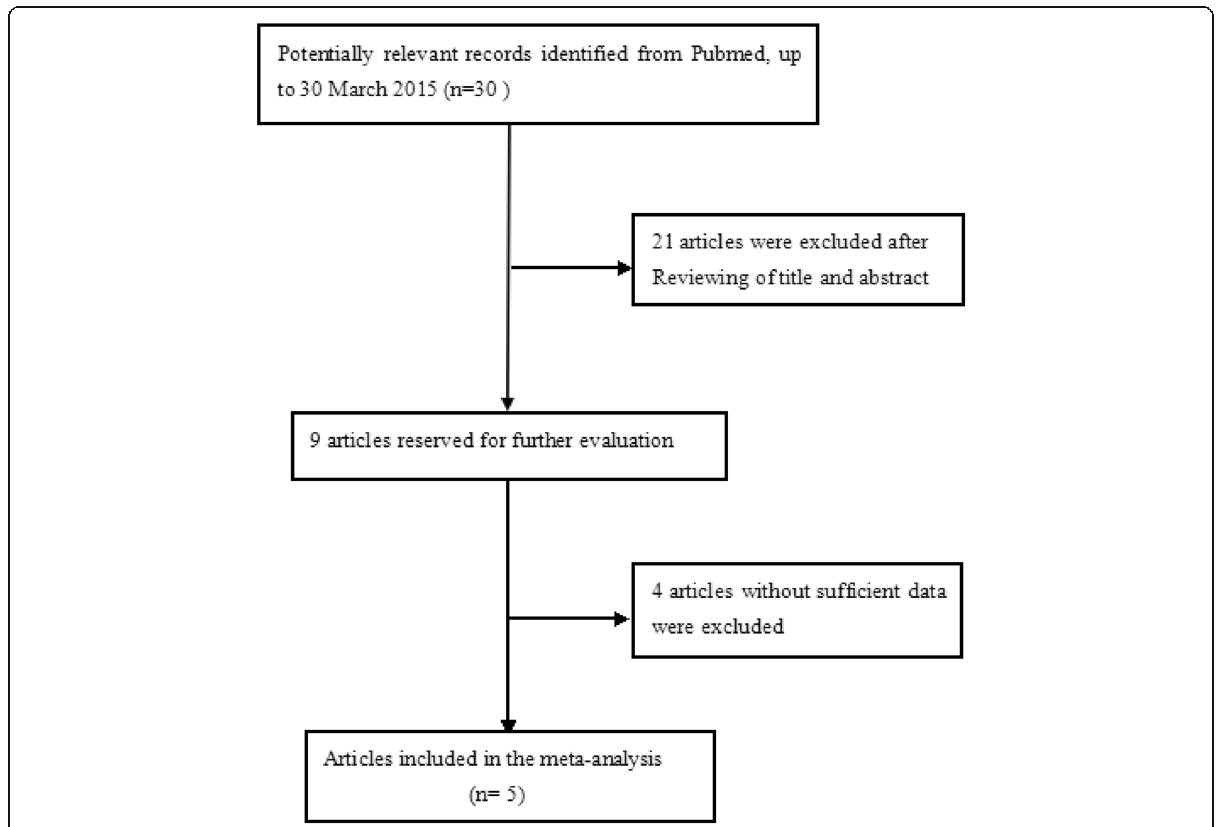
Fig. 1 The flow chart of study selection